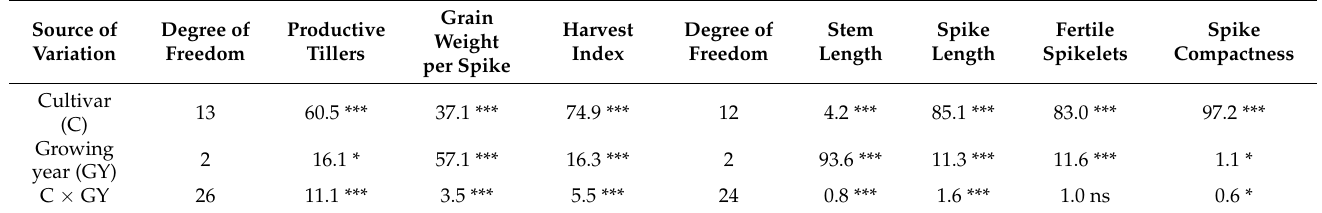
Table 3. ANOVA mean square per source of variation as percentage of total for agro-morphological